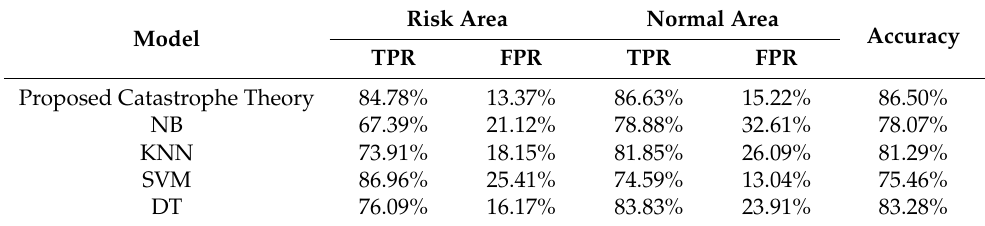
Table 4. Regional risk prediction results of different